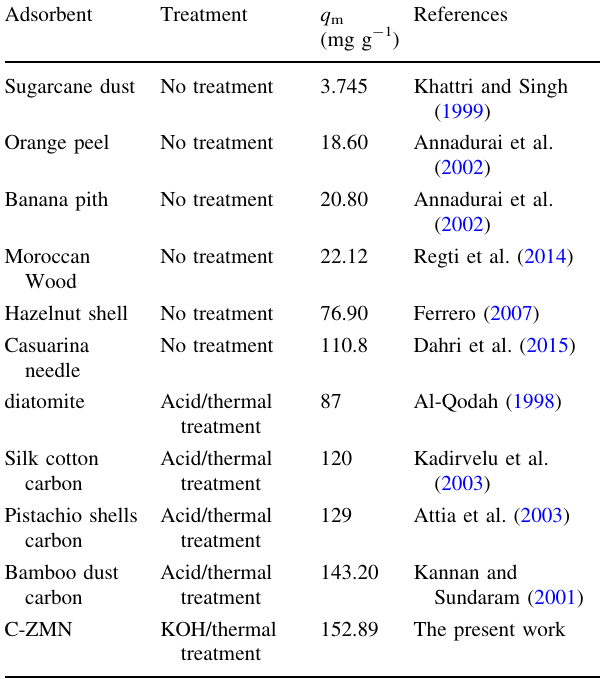
Table 4 Comparison of adsorption capacities of various adsorbents for